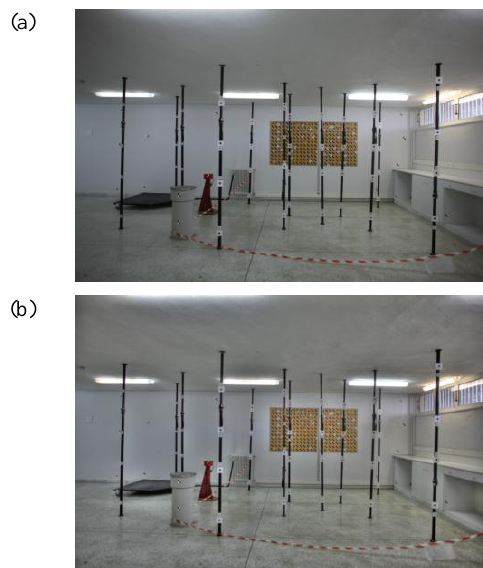
Figure 5: (a) Photo of 0EV of the Control Field taken with 24mm lens and (b) corresponding HDR image